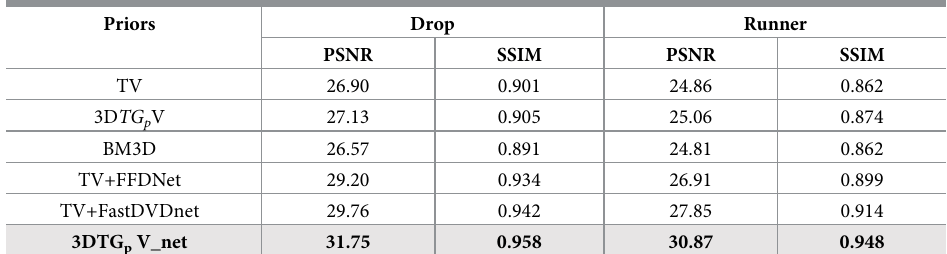
Table 1. Average PSNR and SSIM results. Priors